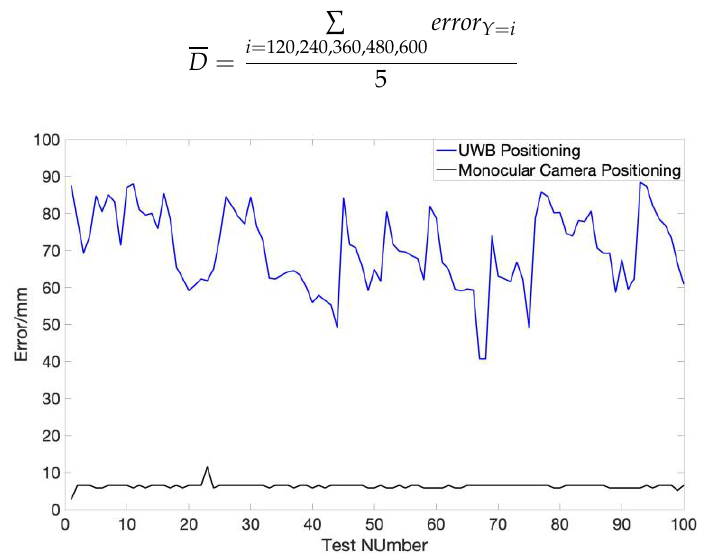
Figure 8. Coordinate (240,240) one hundred times localization error. Table 1. Ultra-wideband (UWB) localization average error of each coordinate point. X -axis